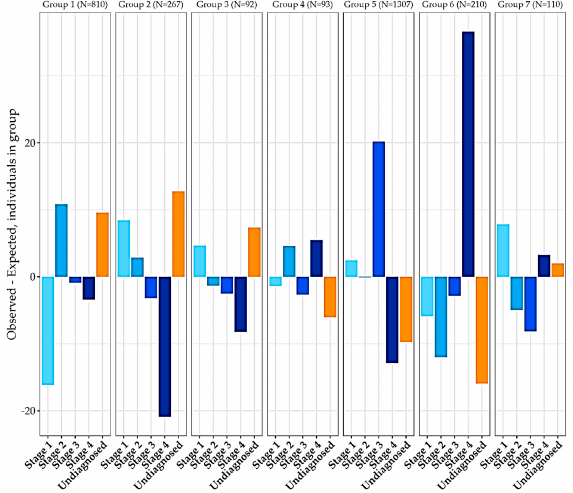
Figure 5. Observed distribution of pain minus expected distribution of pain in relation to stage. The fi gure shows the number of individuals in a de fi ned group and the observed distribution of pain minus the expected distribution of pain in relation to their reported stages. The various stages are shaded. The brightest shade represents Stage 1, while the darkest shade represents Stage 4. The column to the right of “Stage 4” represents participants who were not diagnosed with a speci fi c stage at the time of the completion of the questionnaire. 3. Results Out of 3024 participants from 59 countries who submi tt ed the questionnaire between November 2020 and January 2021, 2964 (98.01%) provided information that enabled the proper analysis of the results (Table 1). The mean age of the participants was 33.2 years (SD: ±7.5) and the distribution of participants between the stages of endometriosis was as follows: Stage 1: 4.8% (n = 142); Stage 2: 9% (n = 267); Stage 3: 14.7% (n = 435); and Stage Table 1. Demographic and clinical characteristics of women with endometriosis who completed the survey. Variable